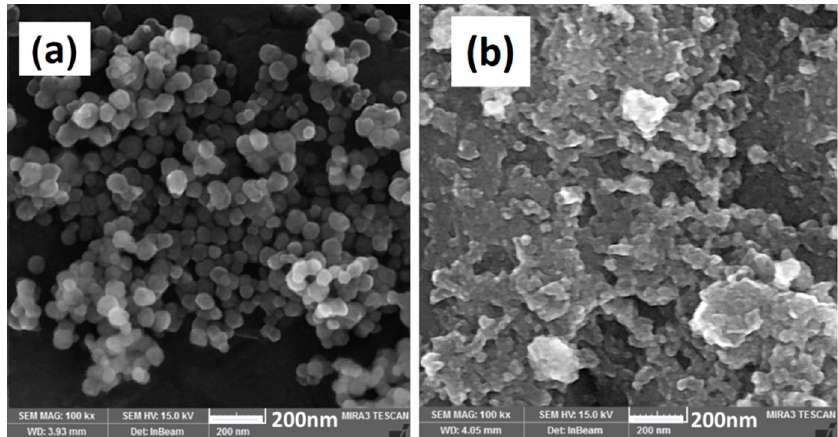
Figure 3. FE ‐ SEM images of ( a ) PVC–MNPs and ( b ) Ni ‐ doped PVC–MNPs [35,36] . Figure 3. FE-SEM images of ( a ) PVC–MNPs and ( b ) Ni-doped PVC–MNPs